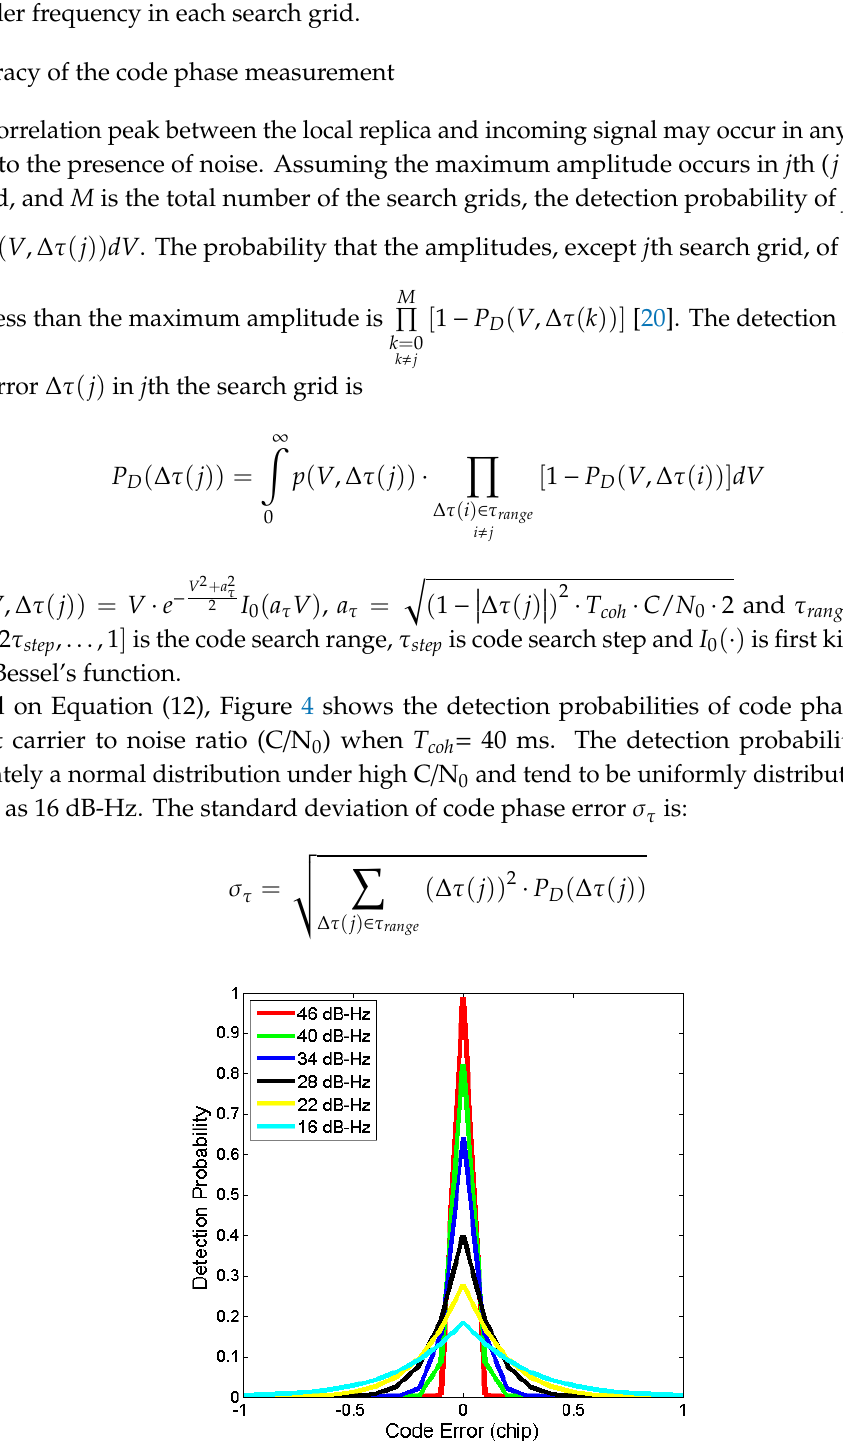
Figure 4. Detection probability of the code phase error.